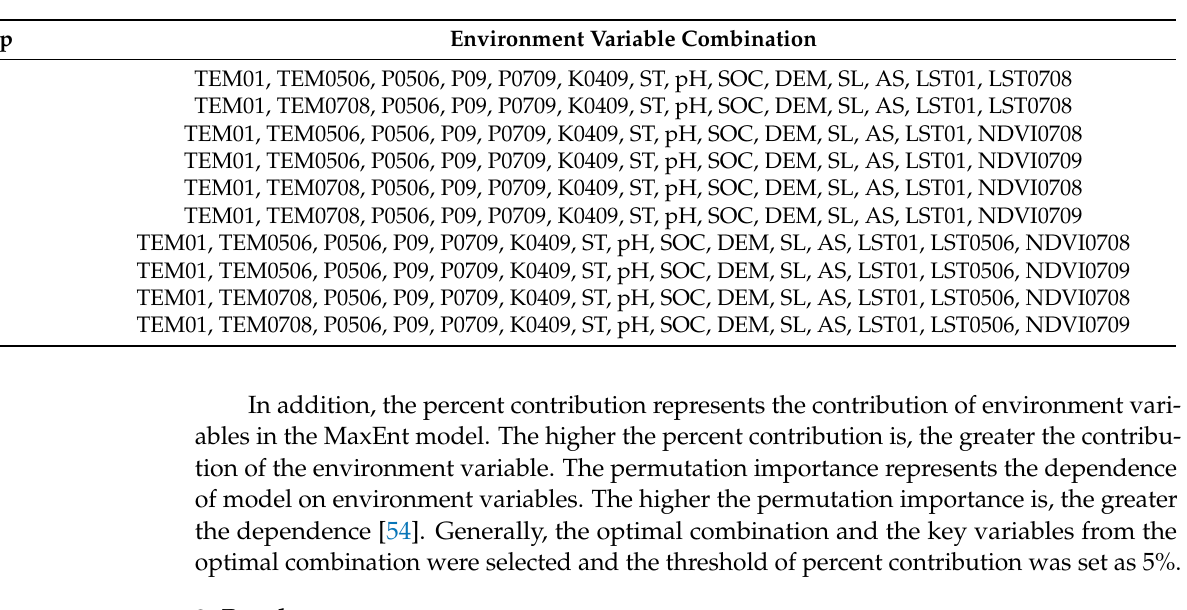
Figure 2. The workflow from data transformation to simulation of MaxEnt model under current and future climate conditions. Table 2. Ten combinations of environment